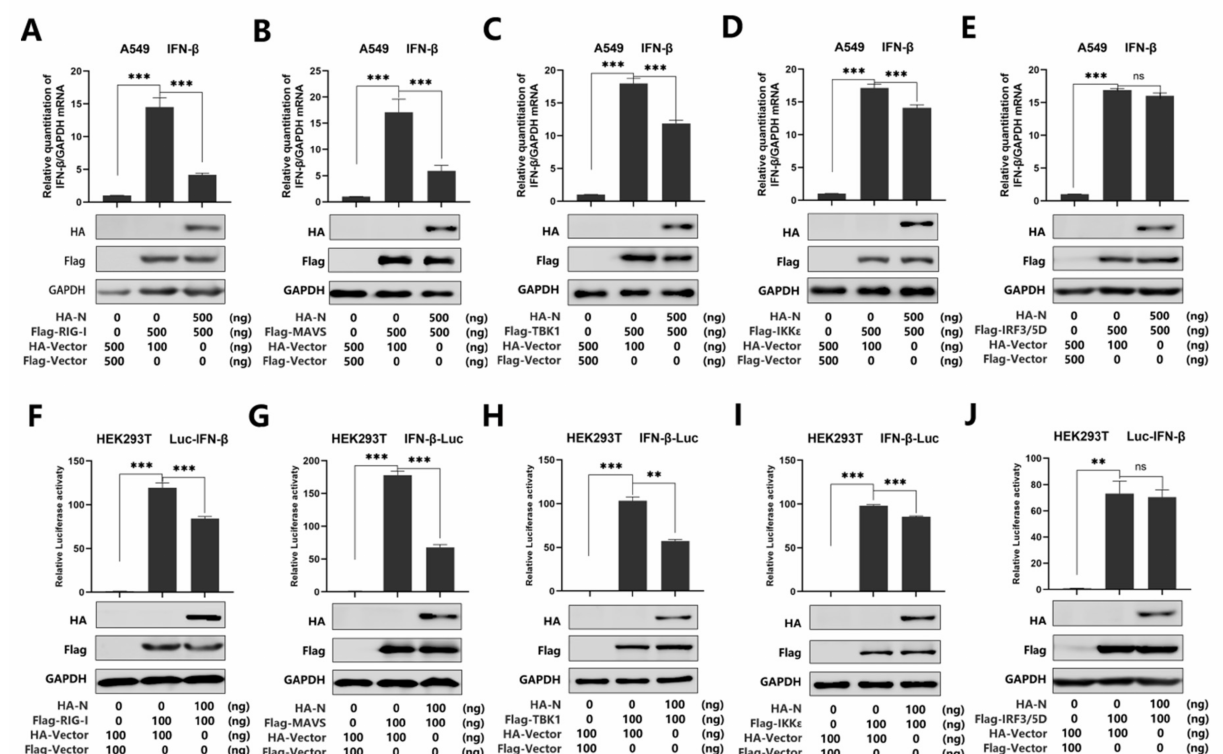
Figure 2. SARS-CoV-2 N protein represses IFN- β production by targeting the RIG-I pathway. ( A – E ) A549 cells were co-transfected with pHA-N, together with pFlag-RIG-I ( A ) or pFlag-MAVS ( B ), pFlag-TBK1 ( C ), pFlag-IKK ε ( D ), of pFlag- IRF3/5D ( E ) for 24 h. Cell lysates were harvested, IFN- β mRNA was determined by q-PCR (top), and HA-N, Flag-RIG-I ( A ), MAVS ( B ), TBK1 ( C ), IKK ε ( D ), and pFlag-IRF3/5D ( E ) were confirmed by Western blotting (bottom). ( F – J ) HEK293T cells were co-transfected with pIFN- β -Luc, pPRL-TK, and pHA-N, together with pFlag-RIG-I ( F ), pFlag-MAVS ( G ), pFlag-TBK1 ( H ), pFlag-IKK ε ( I ), and pFlag-IRF3/5D ( J ) for 24 h. Cell lysates were harvested, IFN- β -Luc reporter activity was determined by dual luciferase reporter assays (top), and HA-N, Flag-RIG-I ( F ), or MAVS ( G ), TBK1( H ), IKK ε ( I ), and pFlag-IRF3/5D ( J ) were confirmed by Western blotting (bottom). Data in A–F were expressed as the mean ± SEM of at least three independent experiments. ns, there was no significant difference, ** p < 0.01, *** p <